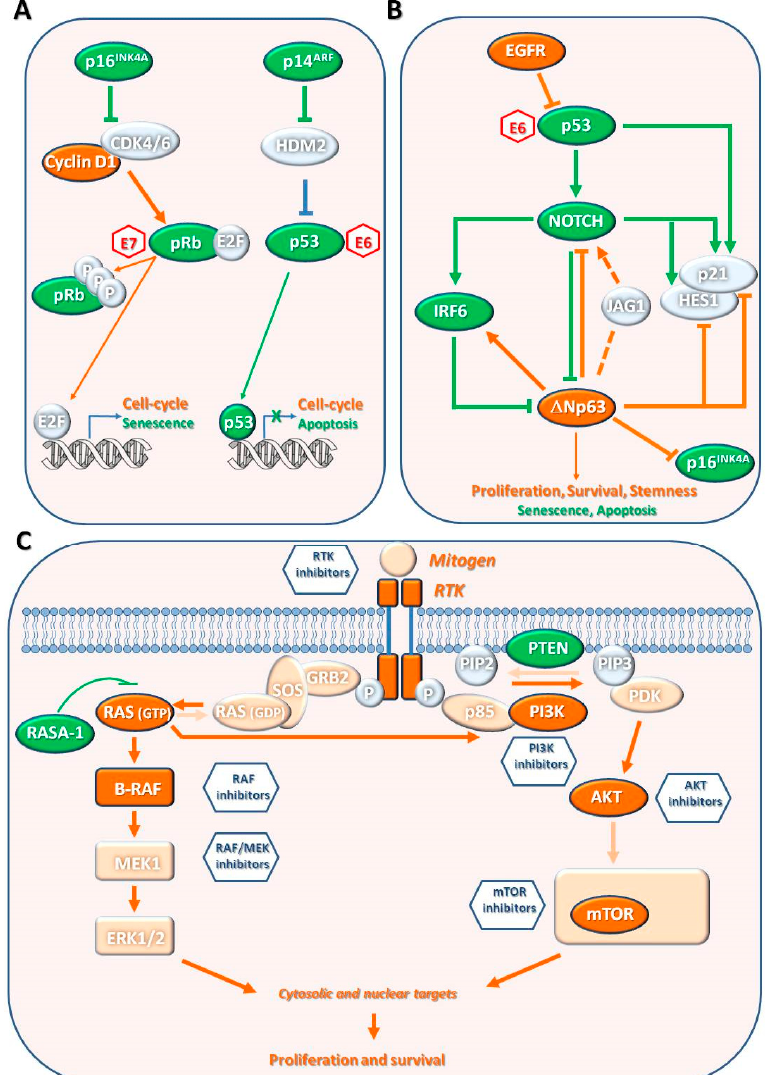
Figure 6. Pathways involved in cutaneous squamous cell carcinoma (cSCC) pathogenesis. Molecular alterations, which drive cSCC development, have been identified in pathways involved in cell cycle regulation, apoptosis, senescence, differentiation, and mitogenic/survival. ( A ) The tumor suppressor genes p16INK4A and p14ARF control retinoblastoma (pRb) and p53 pathways, respectively. Their loss of function promotes cell cycle counteracting senescence or apoptosis. Aberrant activation of E2F transcription can also be due to cyclin D activation or pRb expression loss. pRb and p53 inactivation is also mediated by E6 and E7 (red hexagons) human papilloma virus (HPV) proteins. ( B ) EGF-R aberrant activation, p53 inactivation, or NOTCH gene mutations inactivate the NOTCH pathway. Inactivation of NOTCH abolishes the direct or IRF6-mediated suppression of ∆ Np63, favoring proliferation, survival, and stemness. NOTCH inactivation also counteracts senescence and apoptosis mediated by its targets (HES1 and p21). Moreover, ∆ Np63 upregulation represses the expression of HES1, p21, and p16INK4A. ( C ) RAS-RAF-MEK-ERK and PI3K/AKT/mTOR pathways share the up-stream proteins, such as tyrosine kinase receptors (RTK) and RAS. Activating mutations in RTK, RAS or inactivation of negative regulator RASA1 promotes cell proliferation and survival through constitutive activation of both pathways. Aberrant activation of these pathways can also derive by B-RAF or PI3K/AKT activation, or Phosphatase and tensin homolog (PTEN) inactivation. The RTKs and the downstream pathways can be targeted with several drugs (blue hexagons) to inhibit cSCC progression. However, both pathways can be activated by RAS mutations, present in photodamaged skin, as part of a compensatory mechanism that could drive resistance to therapeutic targeting strategies. Proteins with commonly accepted tumor promoting and suppressing functions are highlighted in orange and green, respectively. Activated or downregulated processes (circles, squares and arrows) are highlighted in dark orange and green, respectively. Block and dash arrows indicate direct or indirect interactions,